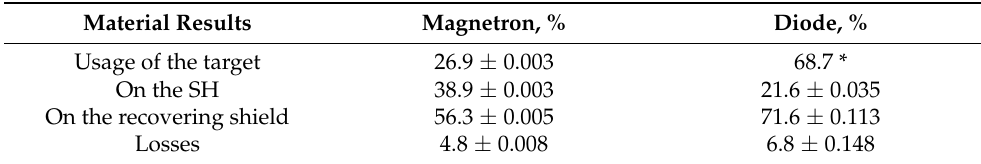
Table 2. Summary of the material dissipation results inside the vacuum chamber for both MS and DS